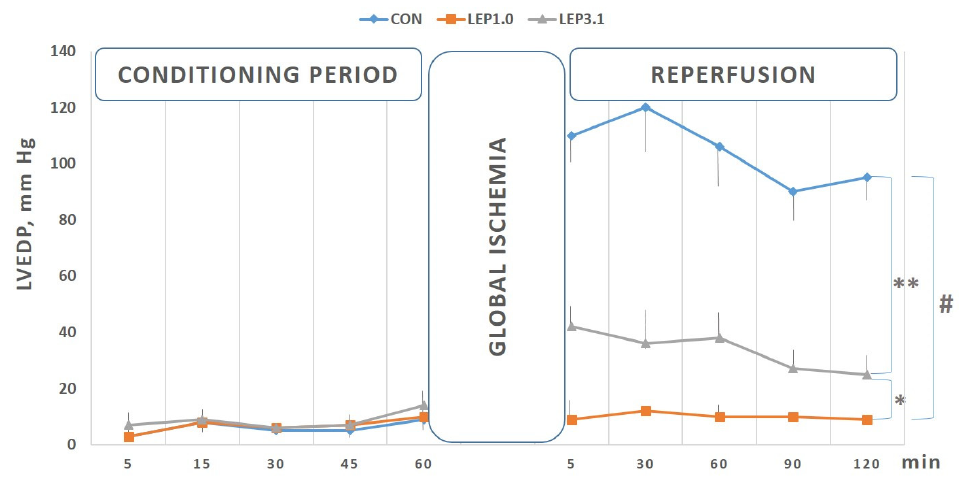
Figure 2. Left ventricular end-diastolic pressure (LVEDP) in the control (CON), leptin 1.0 nM (LEP1.0), and leptin 3.1 nM (LEP3.1) groups. Data are presented as mean ± standard deviation. * p = 0.021; ** p < 0.001; # p < 0.0001.